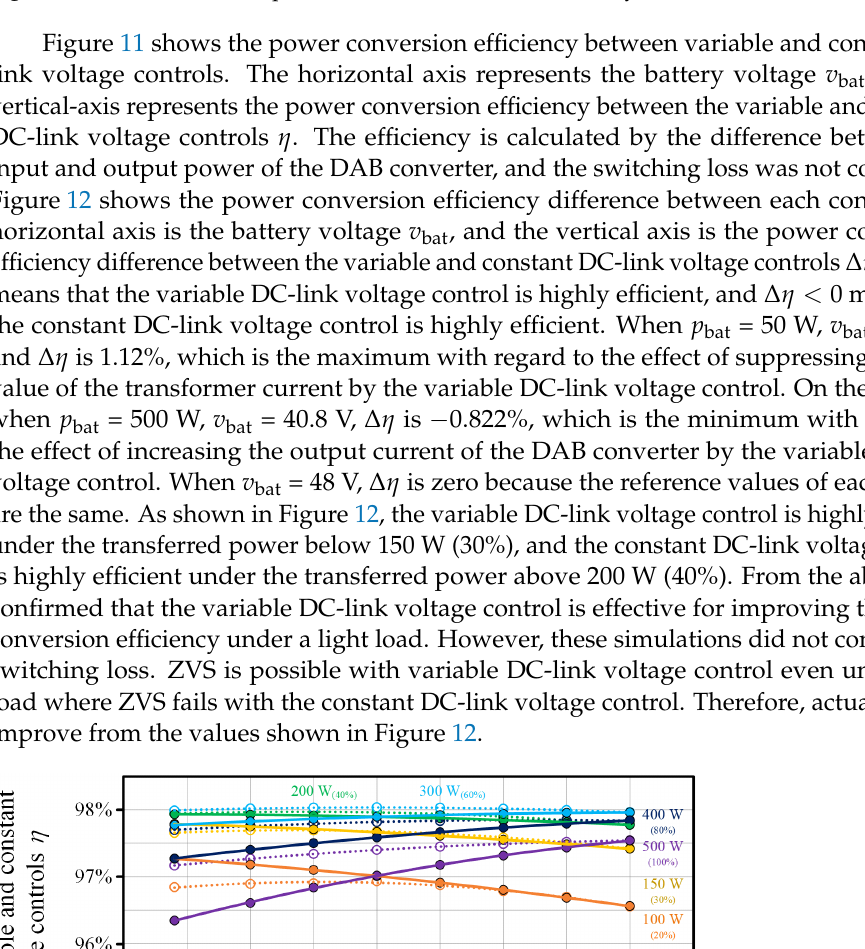
Figure 10. Reduction rate of peak value of transformer current by variable DC-link voltage control.